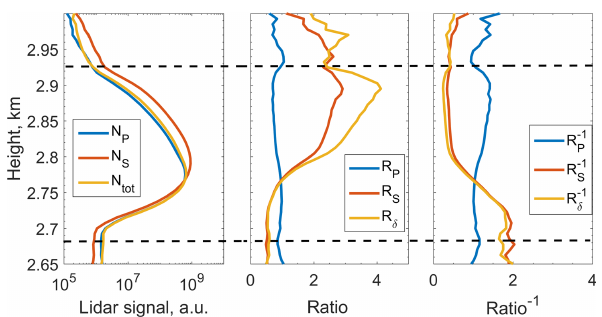
Figure 5. Example of a 5min profile of range-corrected lidar sig- nals from the channels, signal ratios, and inverse ratios. The calibra- tion procedure considers all signals of the 3h measurement period shown in Fig. 4. The dashed line indicates the range in which the calibration calculations were carried